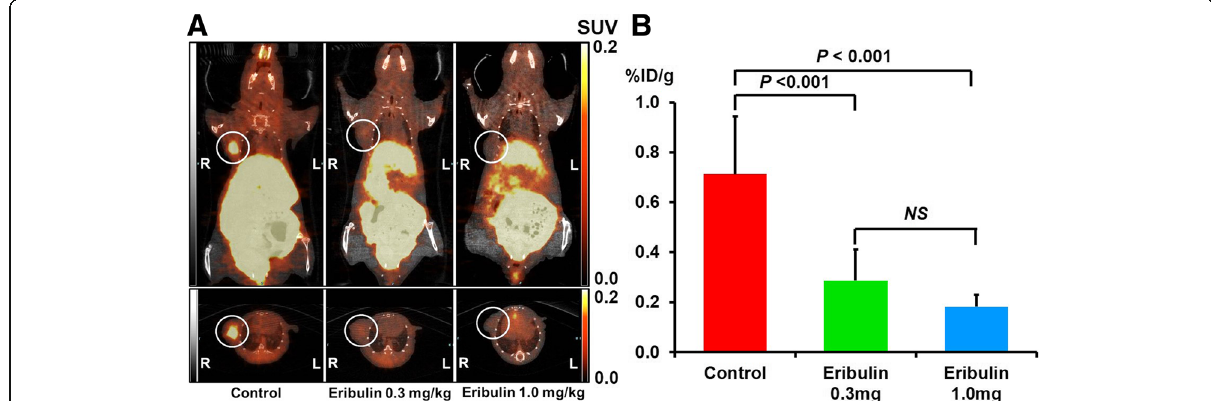
Fig. 2 Representative images of 18 F-FMISO PET ( a ) and intratumoral accumulation levels of 18 F-FMISO ( b ) in ex vivo study groups. The circle shows the tumor region. R, right; L,